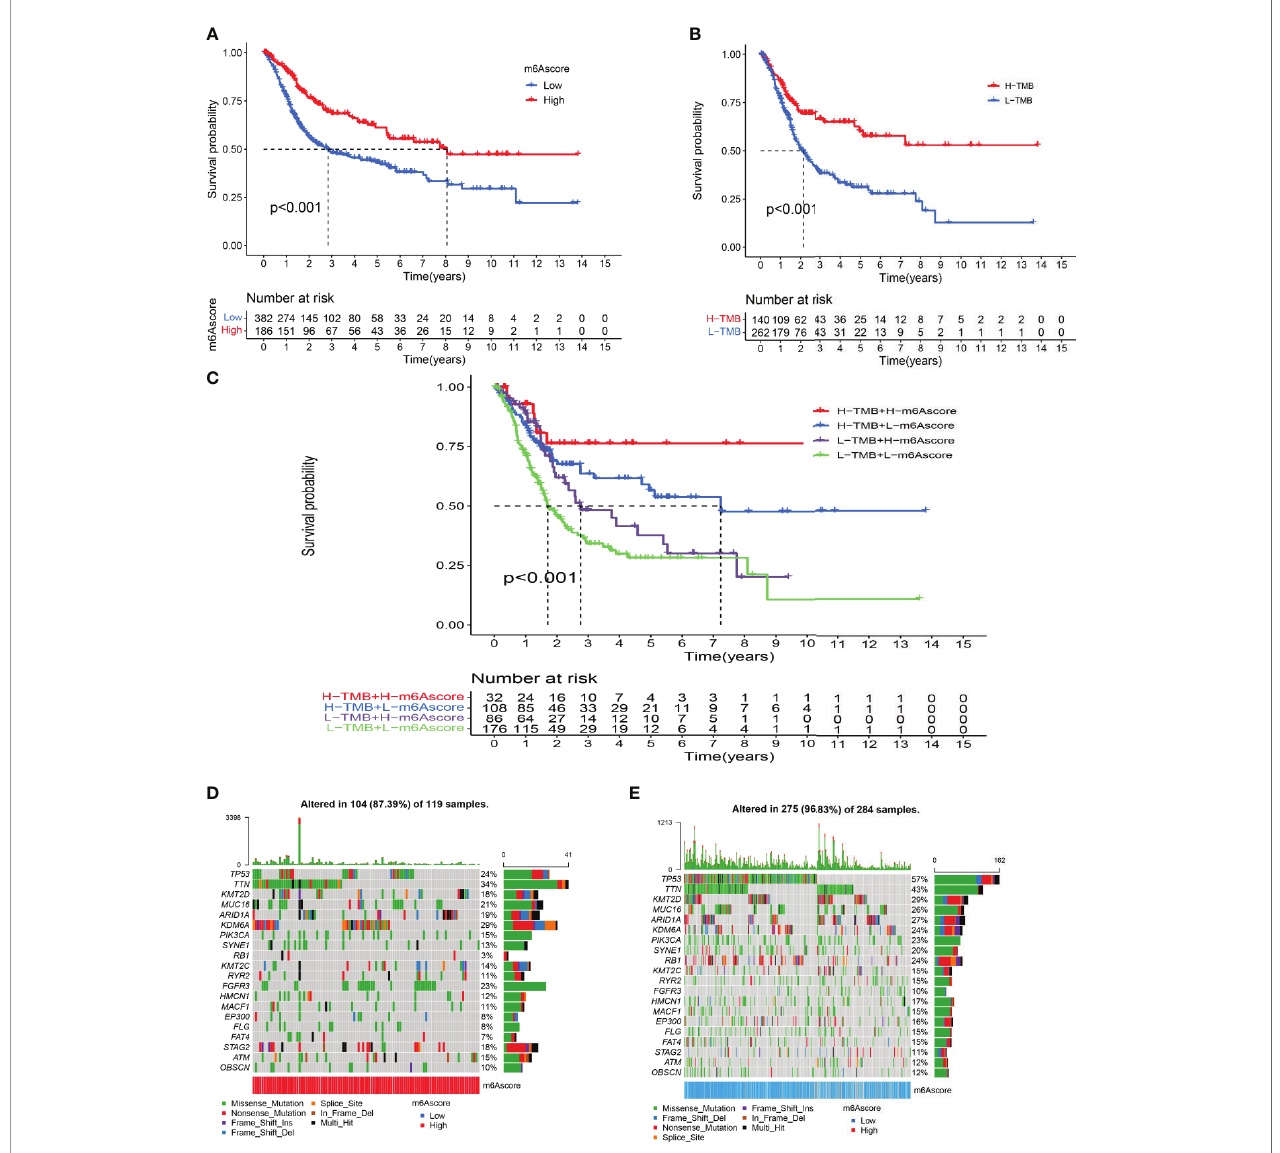
FIGURE 5 | Characterization of m6A modi fi cations in tumor somatic mutation. (A) Survival analysis of the high-m6A score group and low-m6A score group. (B) Survival analysis of tumor mutation burden. (C) Survival analysis of TMB combined with m6A score. (D) Waterfall chart of the high-m6A score group. (E) Waterfall chart of the low-m6A score